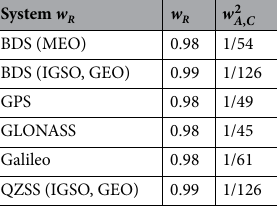
Table 3. Values of weight factors for different systems. These values are mainly related to the satellite